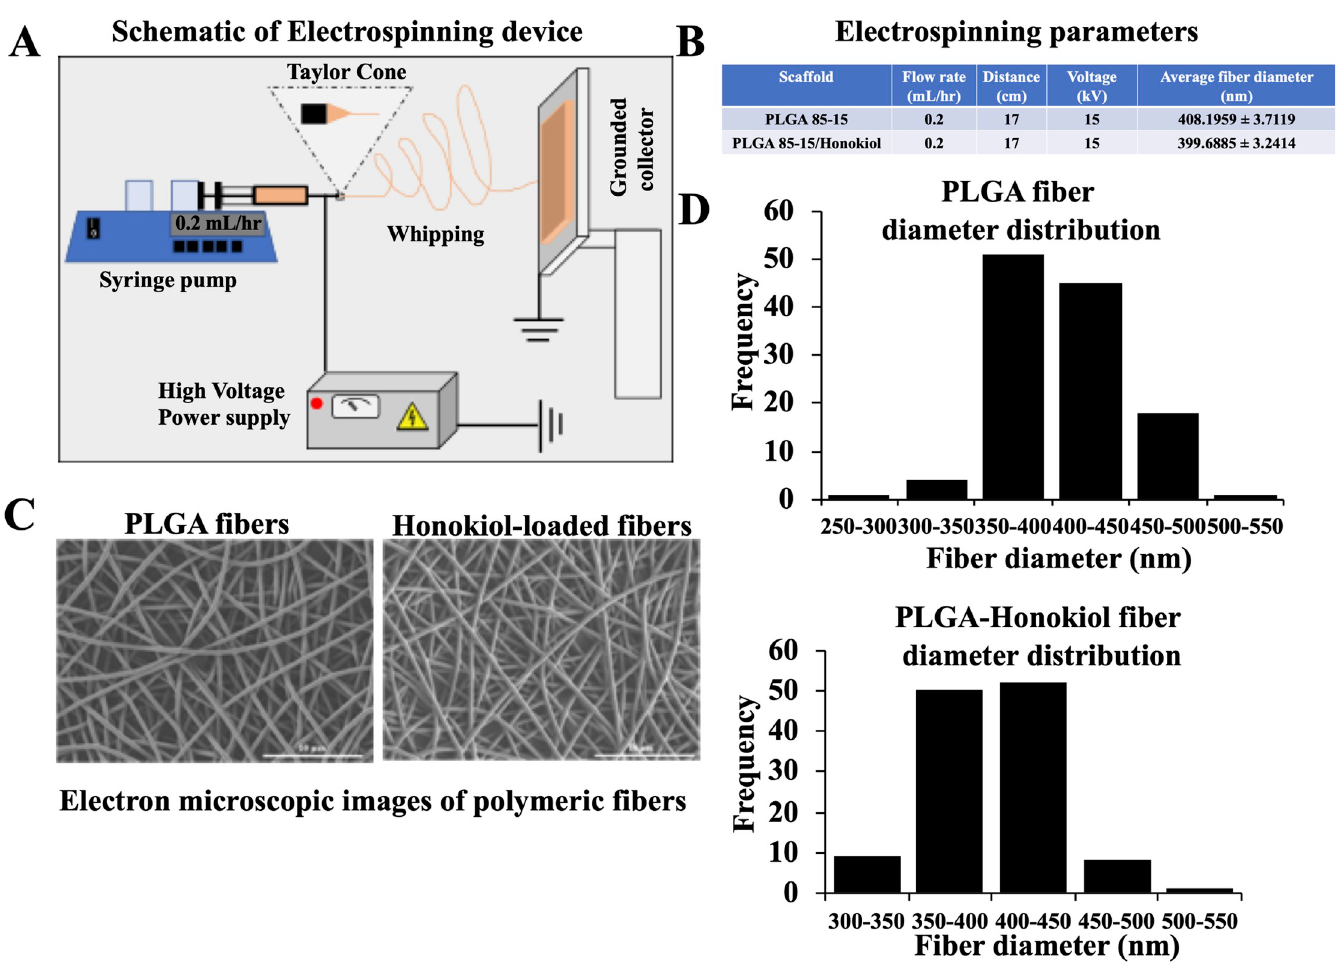
Fig 1. Morphological characterization of control and Honokiol loaded PLGA 85–15 fibers. (A) Schematic representation of the electrospinning process. (B) Summary of the optimized parameters used in the electrospinning process to fabricate continuous bead free fibers. (C) Scanning Electron Microscope pictures of control PLGA 85–15 ( left ), and Honokiol-loaded PLGA 85–15 electrospun scaffold ( right ). (D) Fiber diameter distribution of PLGA 85–15 ( top ) and Honokiol loaded PLGA 85–15 scaffolds ( down ).